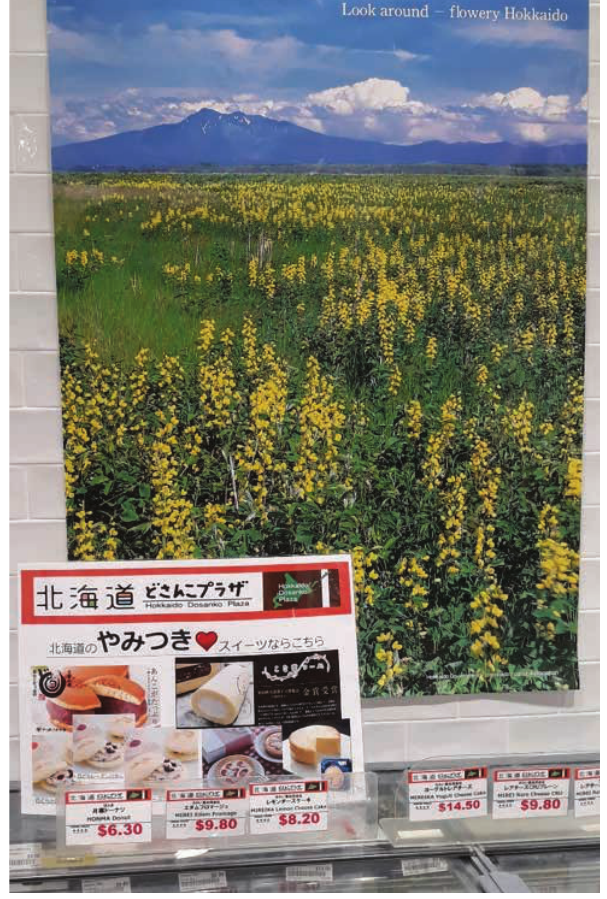
Figure 3: “Look around - flowery Hokkaido” whose fertile fields yield rich dairy products